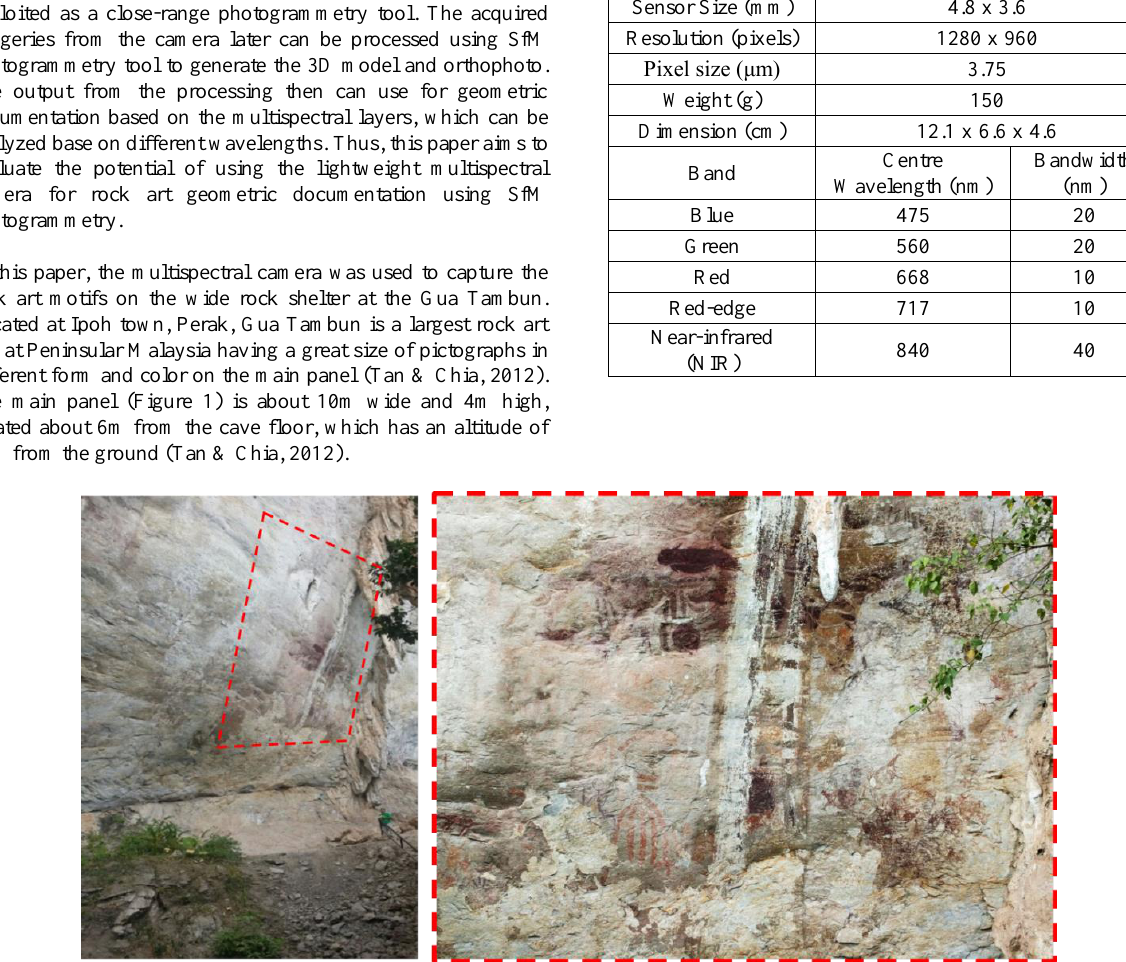
Figure 1: The main panel of the rock art at Gua Tambun. The dashed red box shows the location of the